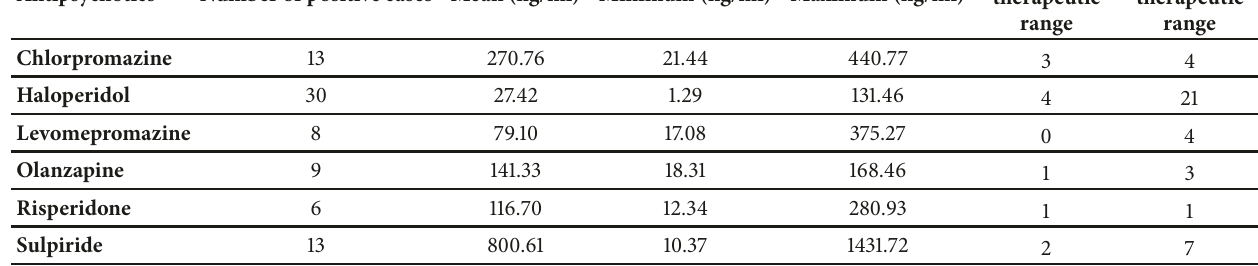
Table 8: Overview of antipsychotic determination in plasma samples taken from 71 patients.